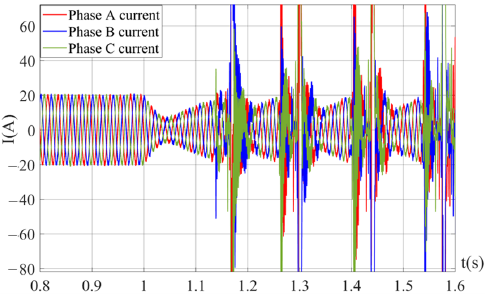
Figure 16. Three ‐ phase currents of AC bus (Group B). Figure 16. Three-phase currents of AC bus (Group B).